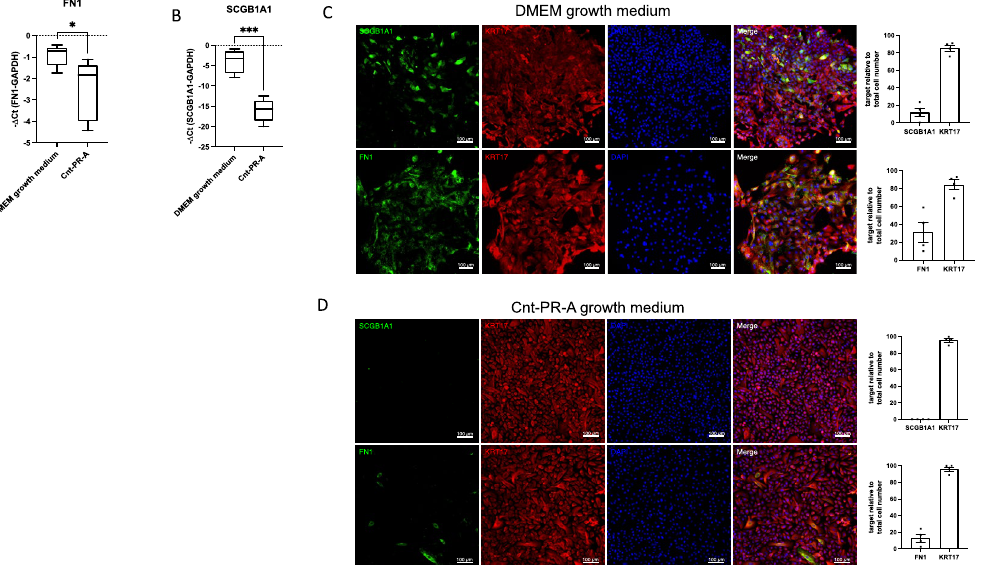
Figure 6. Validation of scRNA data by TaqMan PCR and immunofluorescence stainings. ( A ) FN1 or ( B ) SCGB1A1 RNA expression in cells cultured in DMEM growth medium or Cnt-PR-A ( n = 5). Data are expressed as − ∆ Ct. * indicates p < 0.05, *** indicates p = 0.0002 (unpaired student’s t -test). Immunofluorescence images ( n = 4) showing the co-expression of KRT17 with FN1 or SCGB1A1 in cells cultured in DMEM growth medium ( C , D ) in Cnt-PR-A and their respective quantification relative to the total cell number (DAPI). Dots ( • ) in the bar charts represent the individual datapoints generated from cell stainings of four different